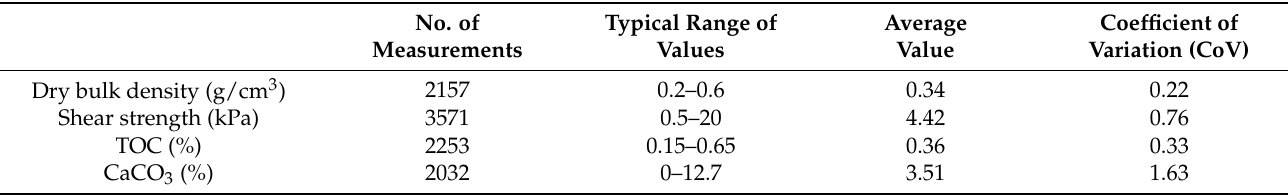
Figure 8. Interpretation of EM120 backscatter data in terms of four different classes. Inset: histogram of the backscatter data in Area E1 showing the boundaries between the four classes. Table 1. Current number of measurements, typical ranges of values and average values of sediment properties as measured in sediments (0–40 cm depth) of 279 box core sites in Area